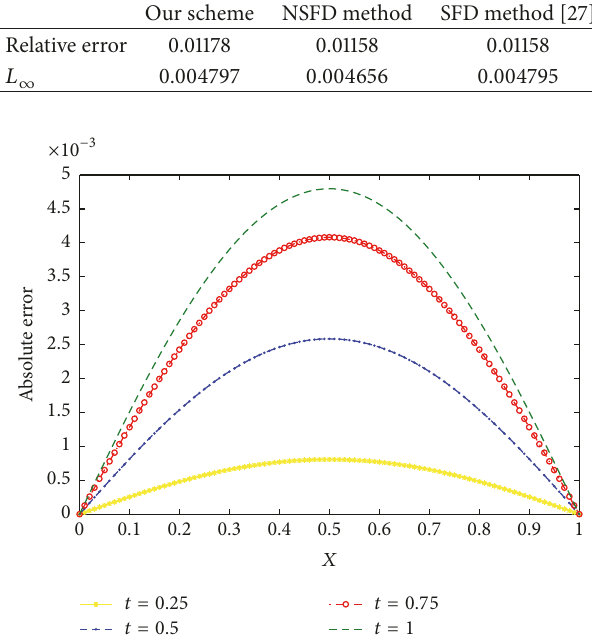
Figure 5: Absolute errors for different values of 𝑡 , Example